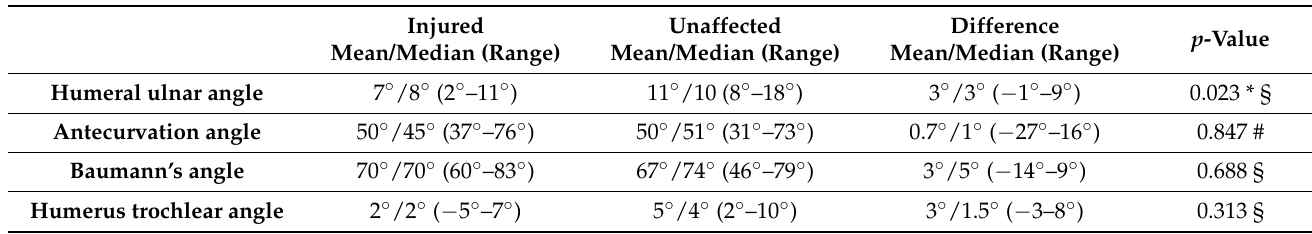
Table 4. The radiological analyses specific to SCHFs (* = statistically significant